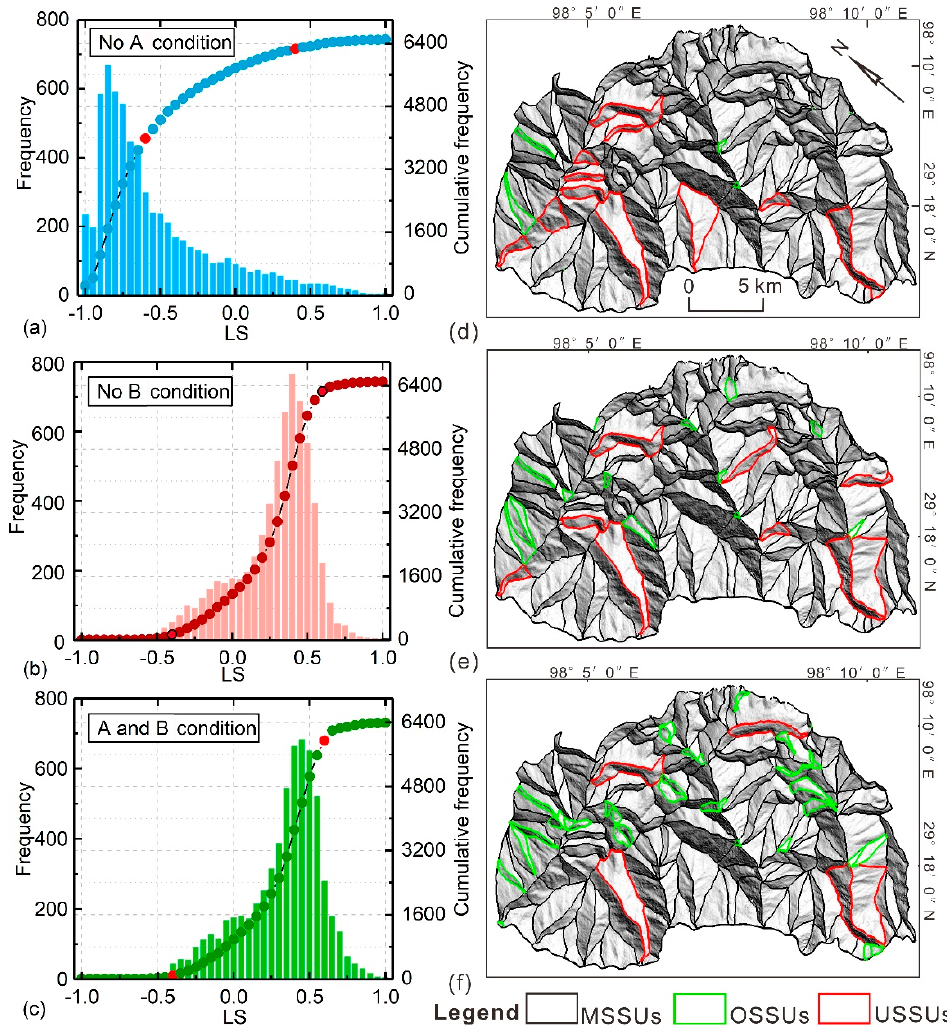
Figure 7. The classification for USSUs, OSSUs and MSSUs from three different calculation methods. ( a – c ) is the frequency distribution and discontinuity point respectively by No A, No B, and A and B condition. The corresponding classification results are shown in ( d – f ).